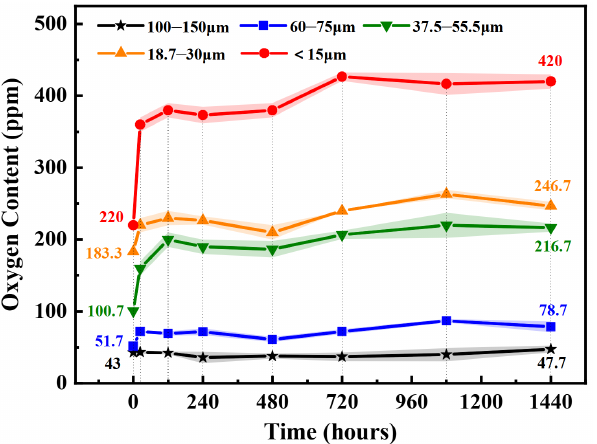
Figure 3. Oxygen contents of the studied superalloy powder after exposure for different time in air.